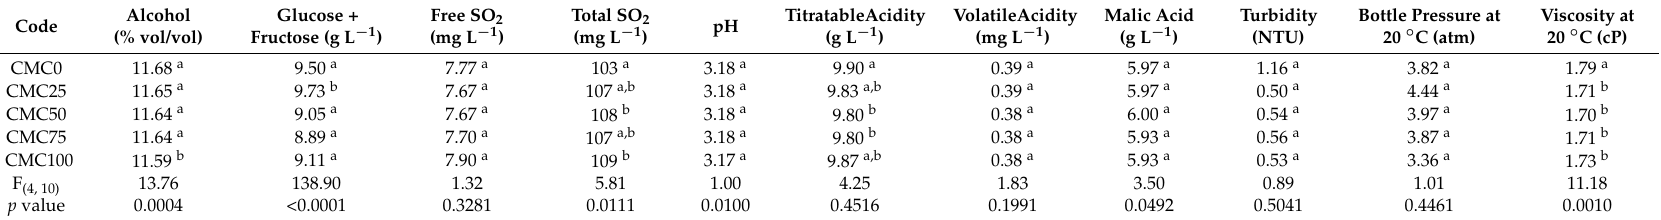
Table 1. Key characteristics of wines prepared with different rates of CMC added at the dosage